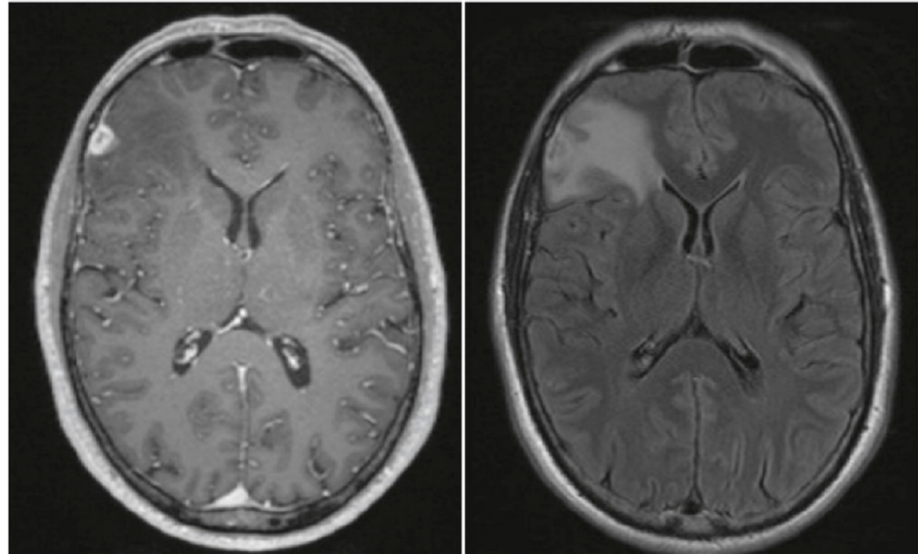
Figure 1. Magnetic resonance imaging of the neurocranium showed a small right frontolateral dural-based contrast-enhancing lesion measuring approximately 1.5 cm in diameter with perifocal oedema ( left , T1-weighted sequence with contrast enhancement; right , fluid-attenuated inversion recovery (FLAIR) sequence).